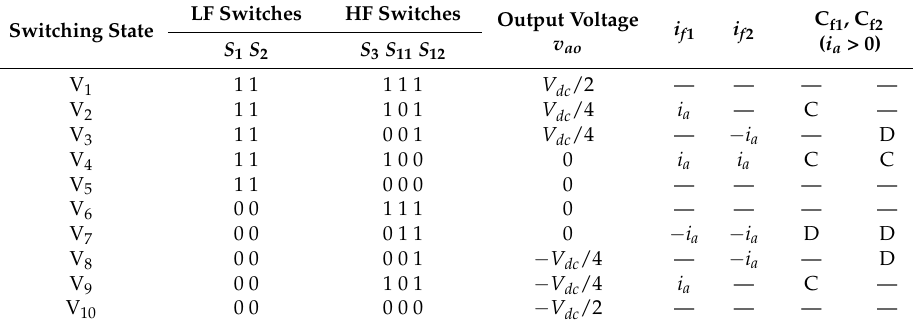
Table 7. Operation of 7L hybrid T ‐ ANPC converter.